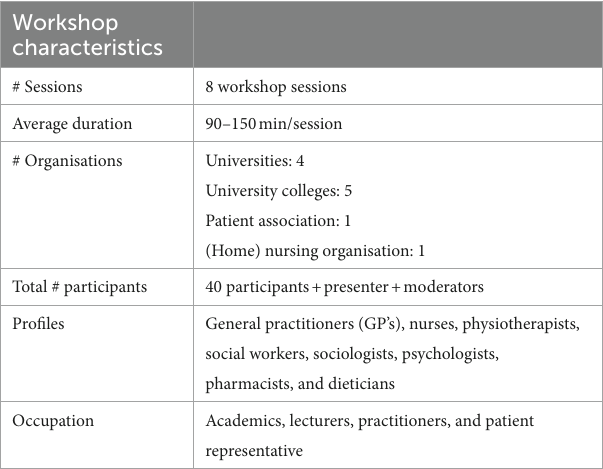
TABLE 1 Overview of co-design workshop